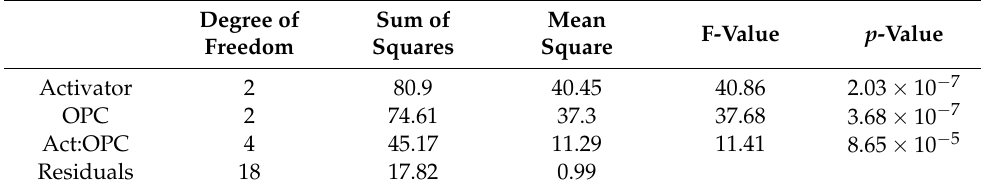
Figure 7. Box and whiskers plot: ( a ) UCS vs. Activator and ( b ) UCS vs. % OPC. Table 4. Two-way ANOVA results factorial